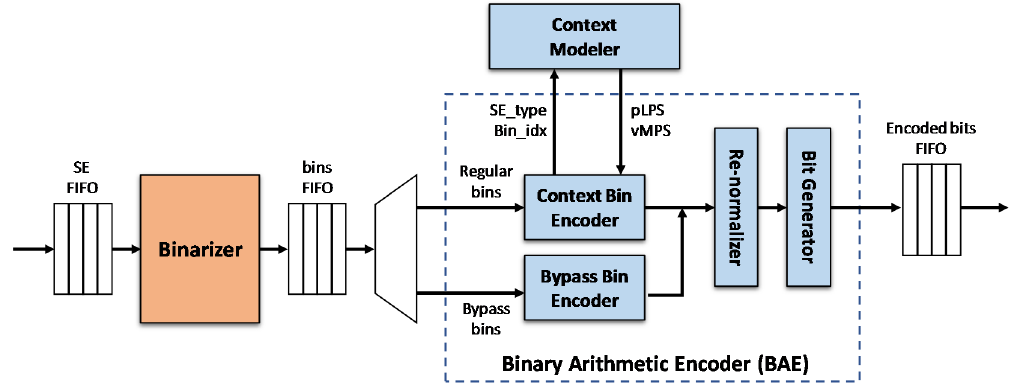
Figure 1. General hardware architecture of CABAC encoder.